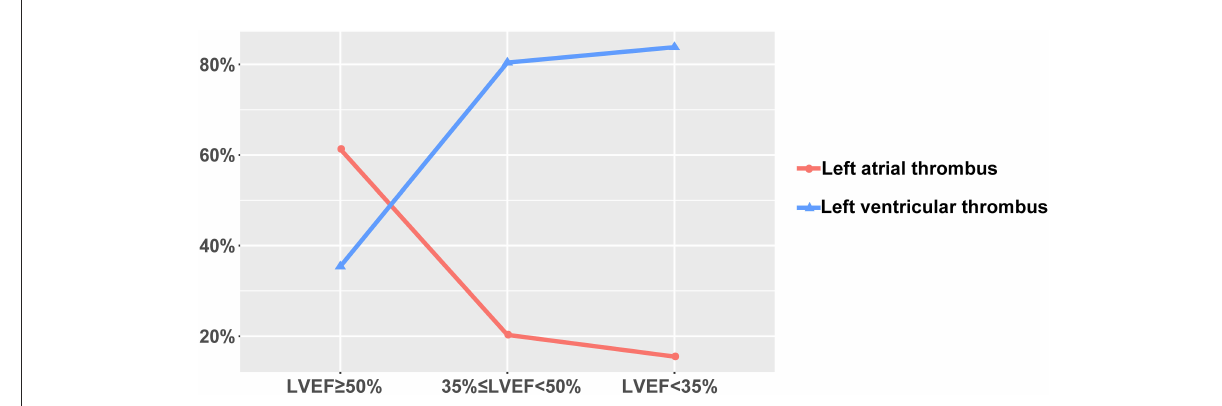
FIGURE2 Left ventricular/atrial thrombus incidence rate according to LVEF phenotypes (%).